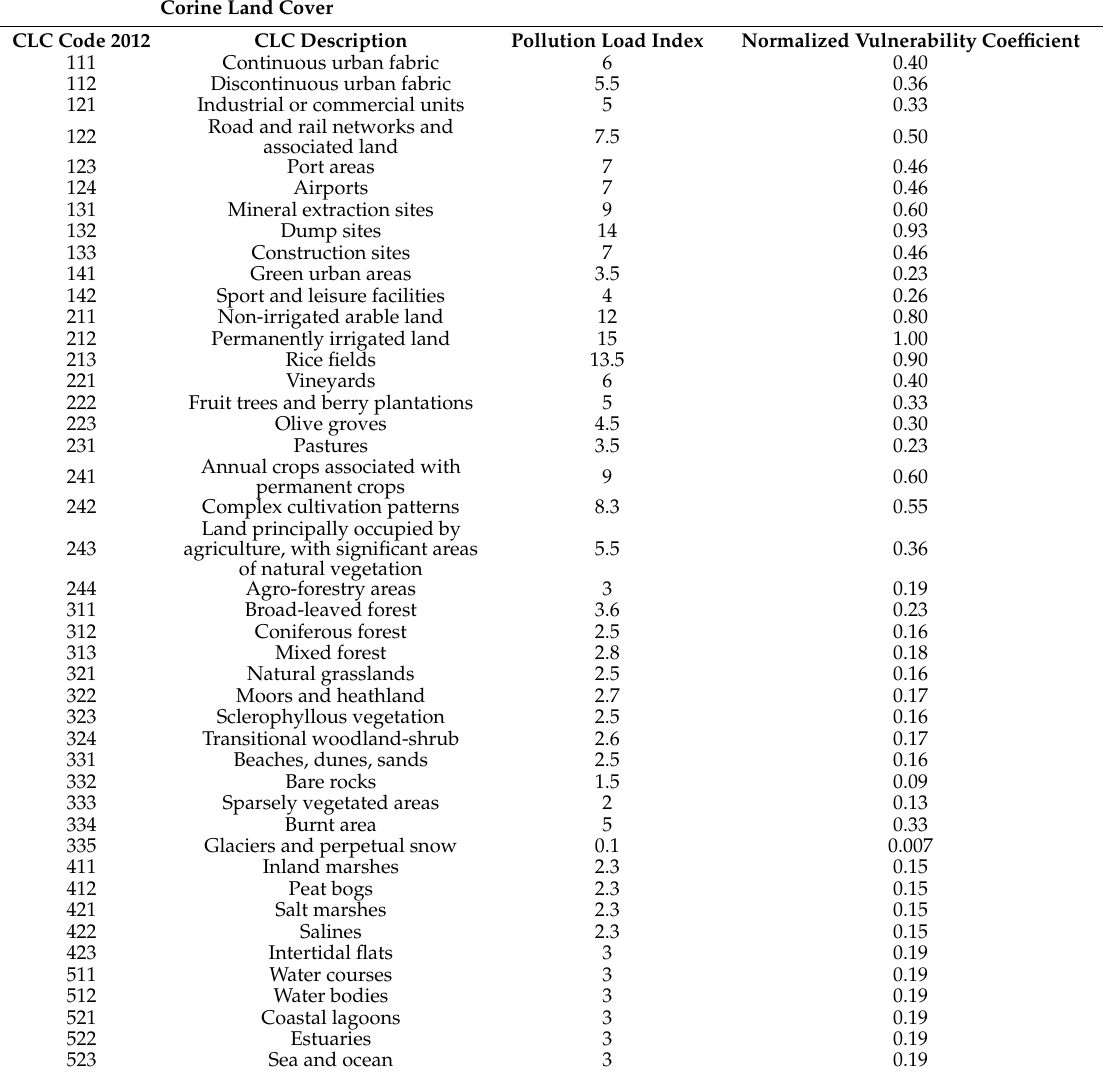
Table 2. Corine land cover classes and relative pollution load index applied for CLC 2000 and 2012, in the Piedmont region.